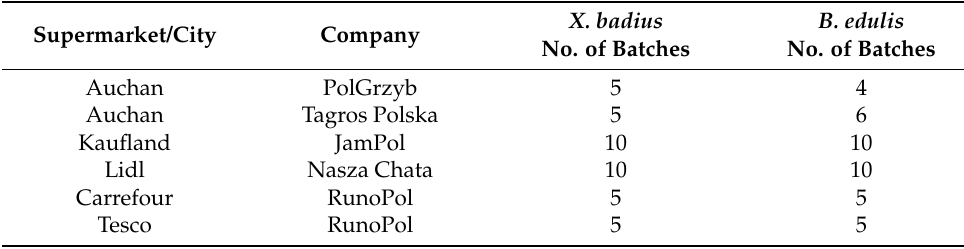
Table 1. Characteristics of studied samples of